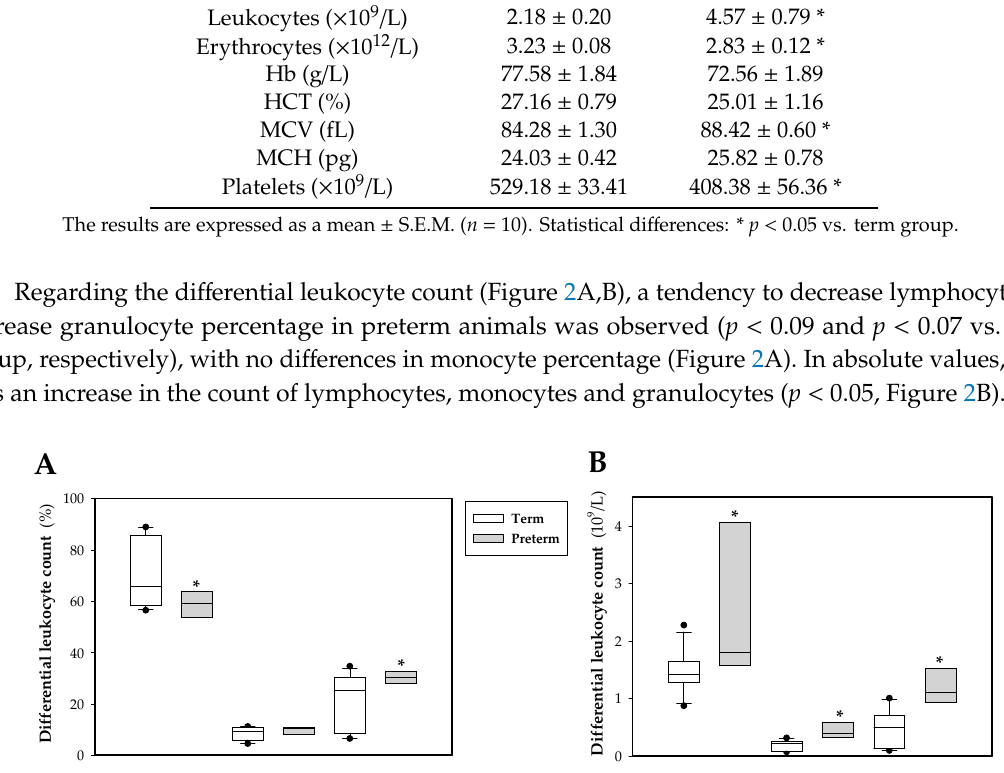
Table 2. Blood cell count from both groups: term and preterm at day 10 of suckling period. Term